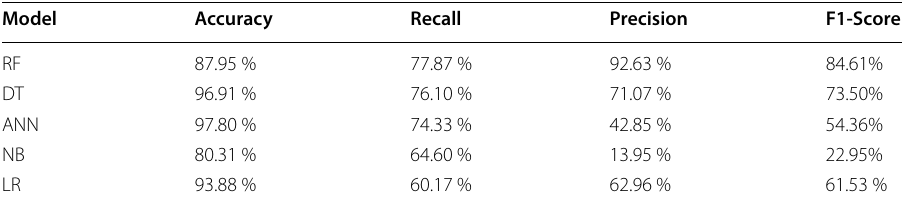
Table 7 Classification results for full feature